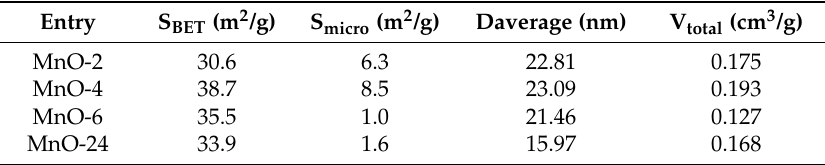
Table 1. Surface characterization of different samples.